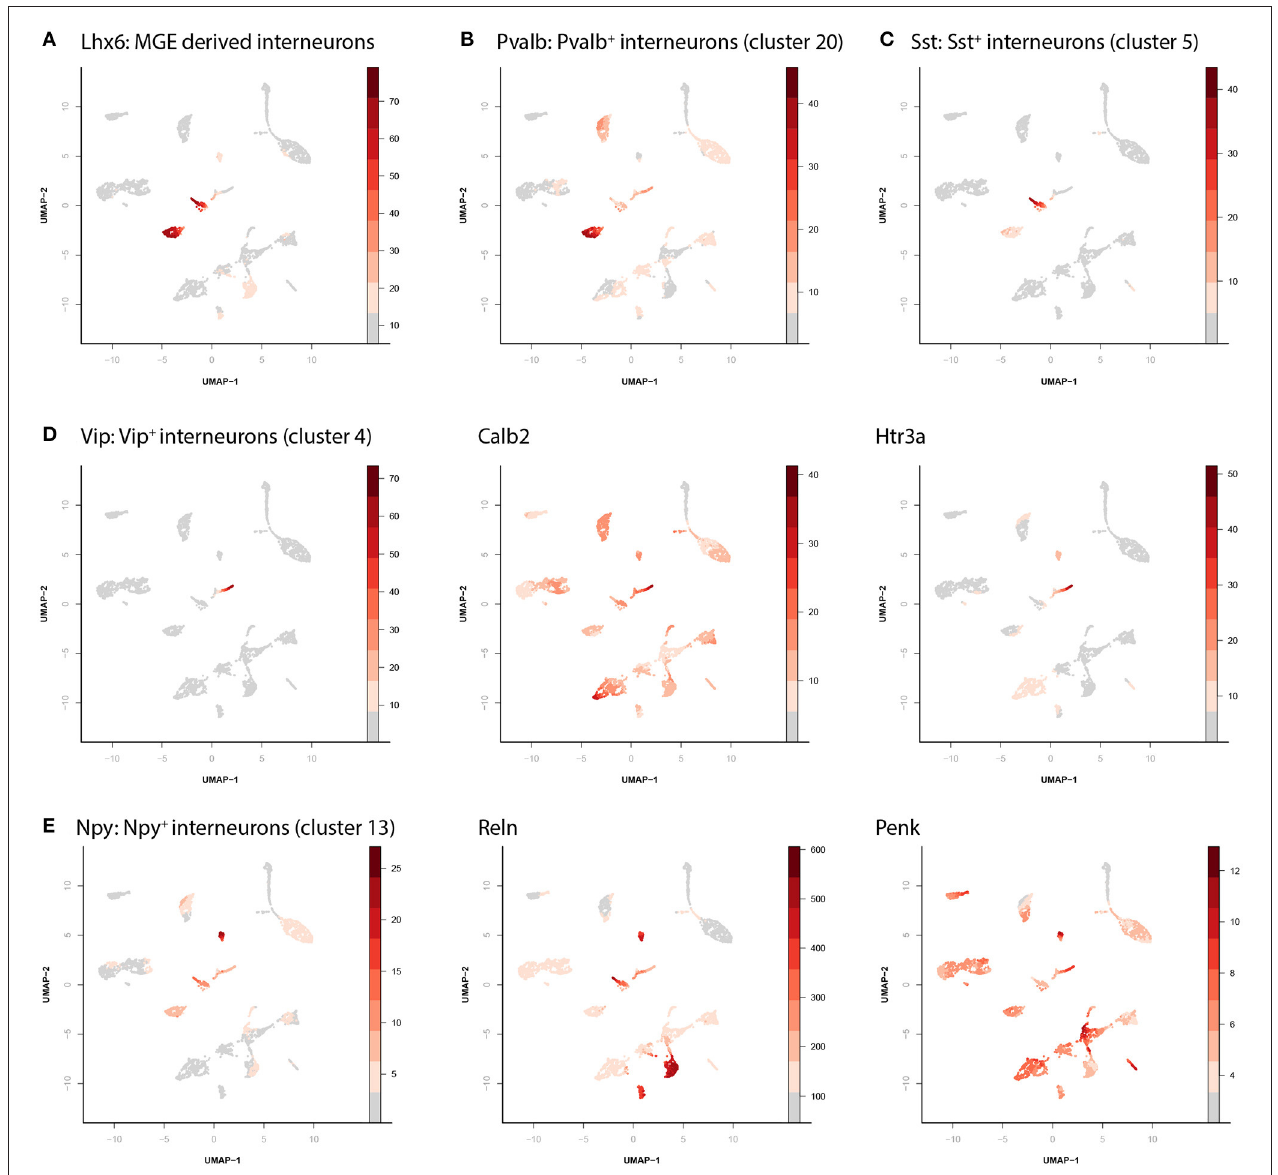
FIGURE 2 | Identification of interneuron cell types. (A) There are four different clusters containing inhibitory neurons. Different marker genes can identify the identity of each of these. Here the relative accessibility score of Lhx6 labels the MGE derived interneurons. (B) Accessibility of parvalbumin labels parvalbumin positive interneurons (cluster 20). (C) Accessibility of somatostatin labels somatostatin positive interneurons (cluster 5). (D) Accessibility of vasoactive intestinal peptide ( VIP ), calbindin , and 5-Hydroxytryptamine Receptor 3A ( Htr3a ) labels the VIP + interneurons (cluster 4). (E) Accessibility of neuropeptide Y ( NPY ), Reelin , and proenkephalin ( Penk ) labels the NPY + interneurons (cluster 13).